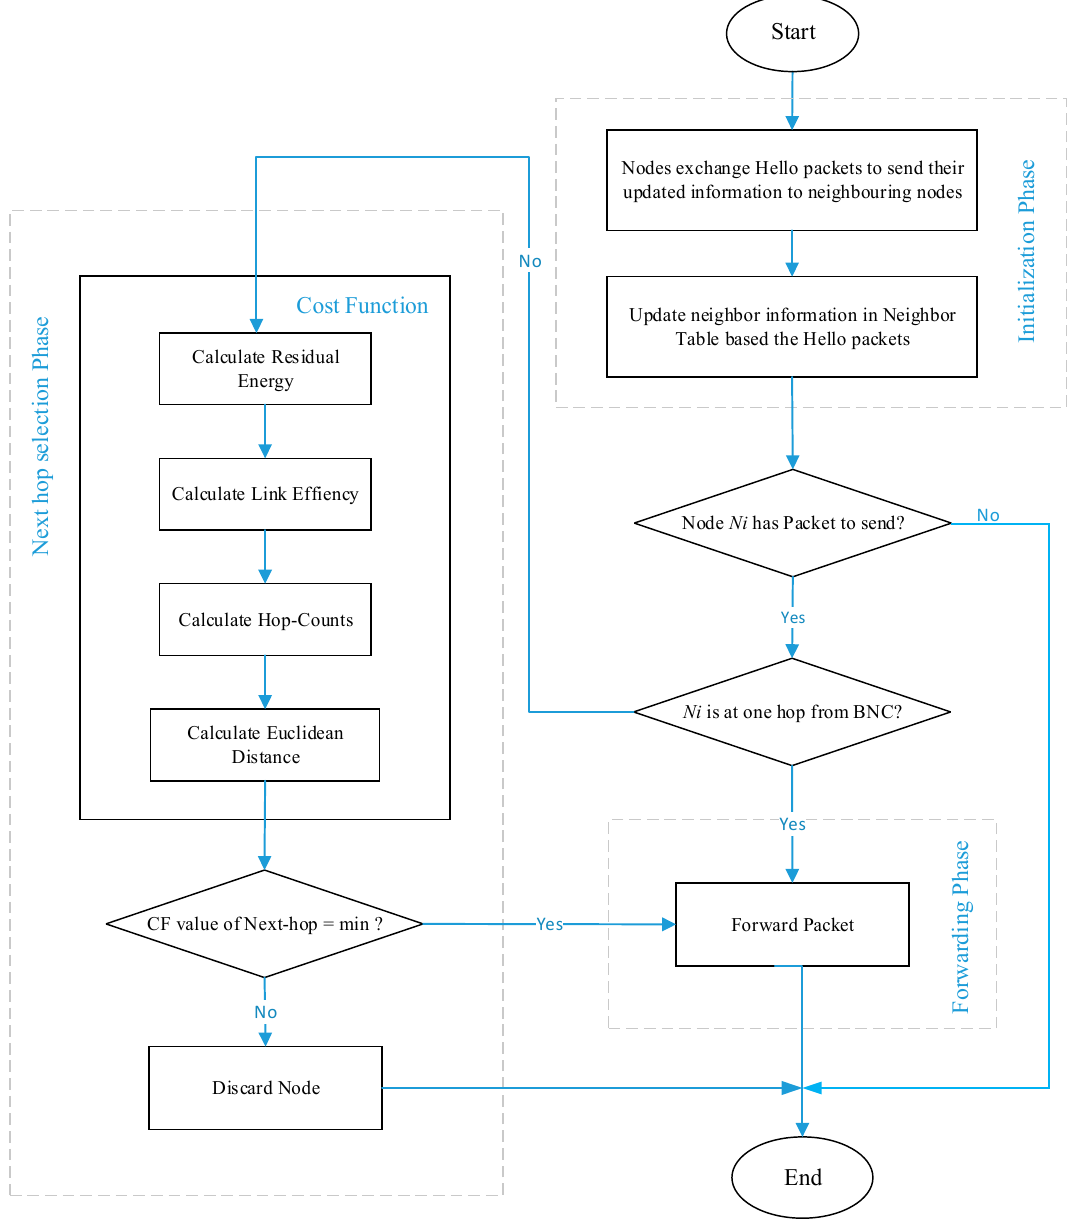
Figure 3. Flow chart of ELR-W protocol.